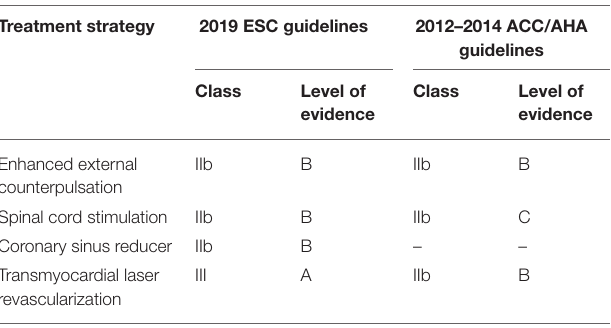
TABLE 1 | Level of evidence of non-pharmacological treatment options in the 2019 ESC and 2012–2014 ACC/AHA guidelines for refractory angina. Treatment